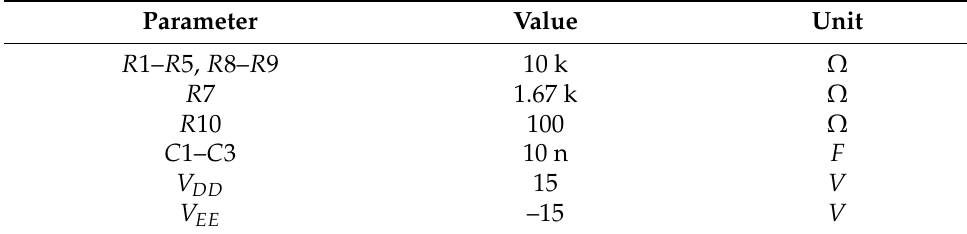
Figure 11. Experimental Setup: ( a ) Oscilloscope, ( b ) Controlled DC Power Supply, ( c ) Breadboard Im- plementation. Table 1. Parameters of Experimental